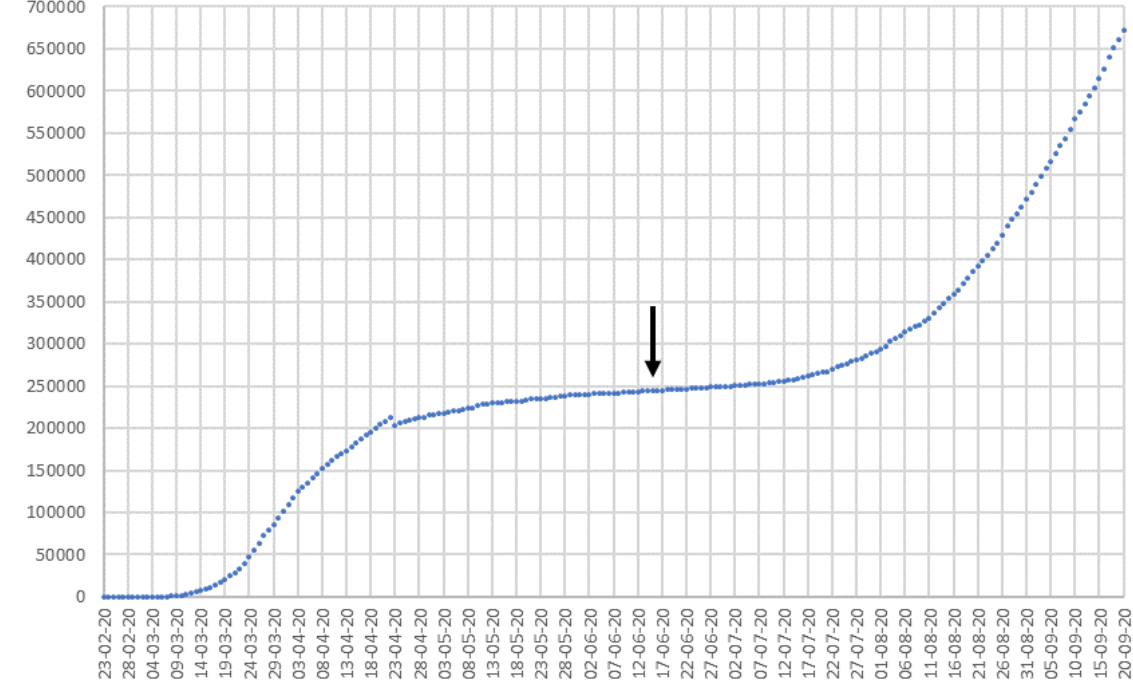
Figure 3. Cumulative number of cases in Spain from 23 February until 20 September. The arrow marks an inflection point at 15 June, which theoretically separates the two pandemic waves. Data source: Centro de Coordinación de Alertas y Emergencias Sanitarias